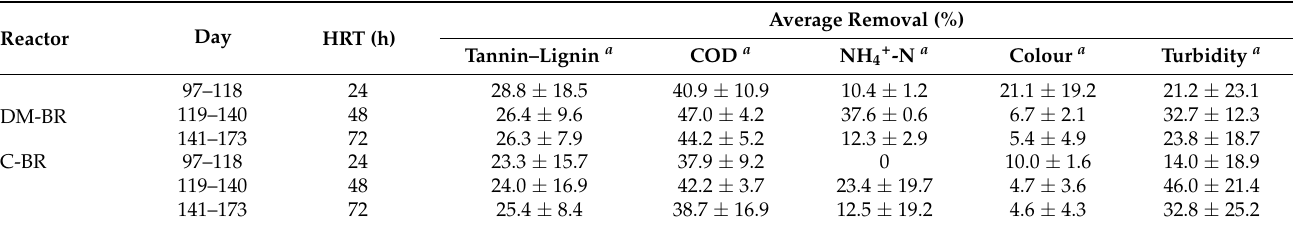
Table 3. Summary of CIE treatment performance by DM-BR and